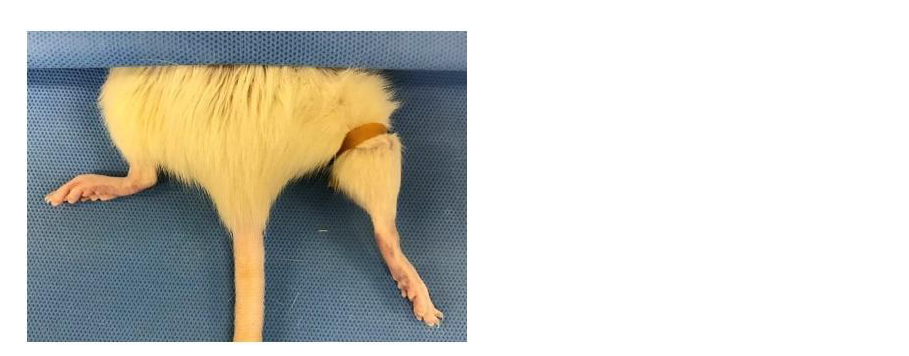
Table 5. Hind limb ischemic preconditioning animal